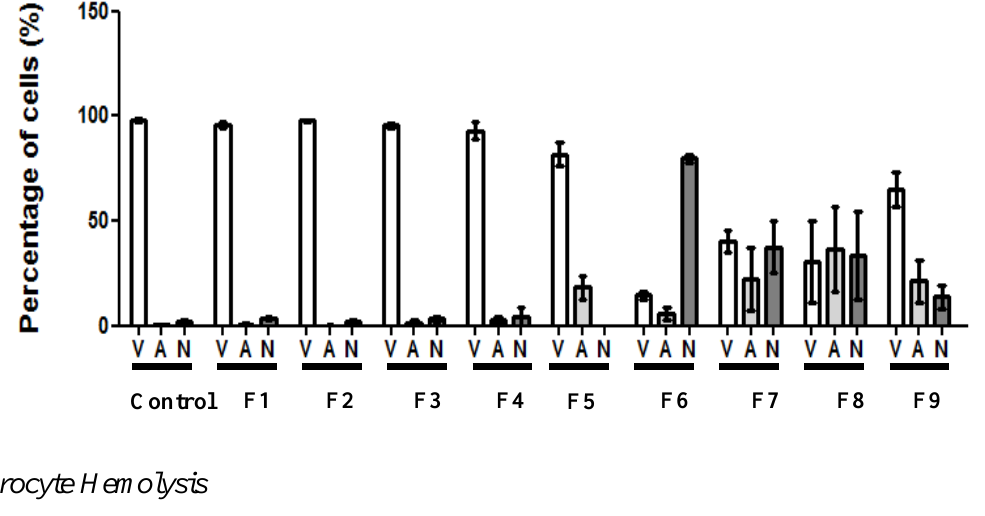
Figure 5. Quantification of viable and dead cells according to morphological identification obtained by double-staining with acridine orange (0.3 mg·mL −1 ) and ethidium bromide (1 mg·mL −1 ) after 24 h of exposition to F1–F9. (V) Viable cells; (A) apoptotic cells; (N) necrotic cells. Data is presented as mean ± SEM from six